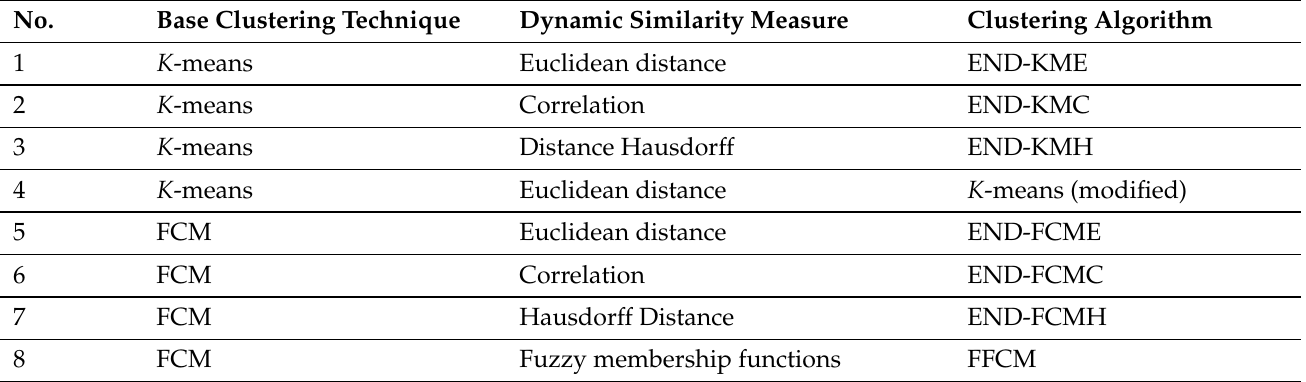
Table 3. Tested clustering algorithms for time